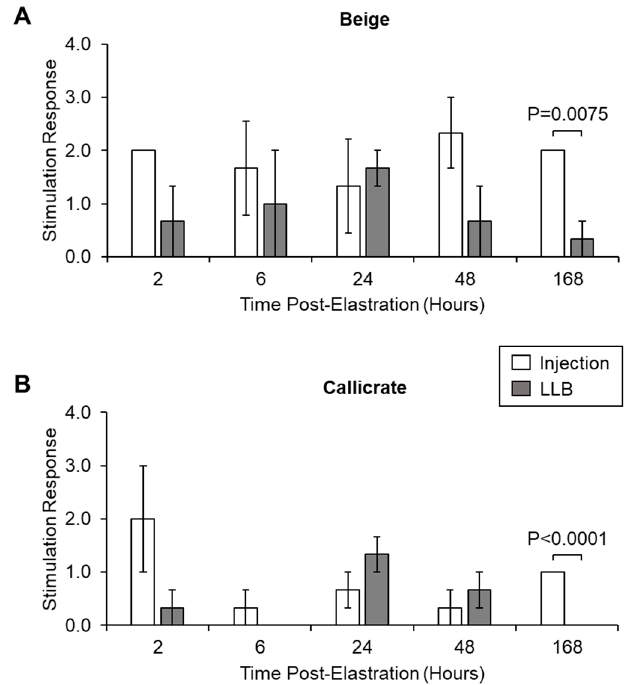
Figure 8. Response of control and treatment calves to electrostimulation at the castration site. Animals were treated with electrostimulation at the banding site and their pain response measured according to a graded scale as described in Materials and Methods. Graded responses for the beige ( A ) and Callicrate TM ( B ) bands were plotted against the duration of band placement for test (LLB) and control (injection) animals. Bars represent the mean ± standard error of the mean (SEM) for three independent replicates per time point. Statistical significance was determined using an unpaired, two-tailed t -test. Data were assessed for normality using a Shapiro–Wilk test. The cutoff for significance was p < 0.05.